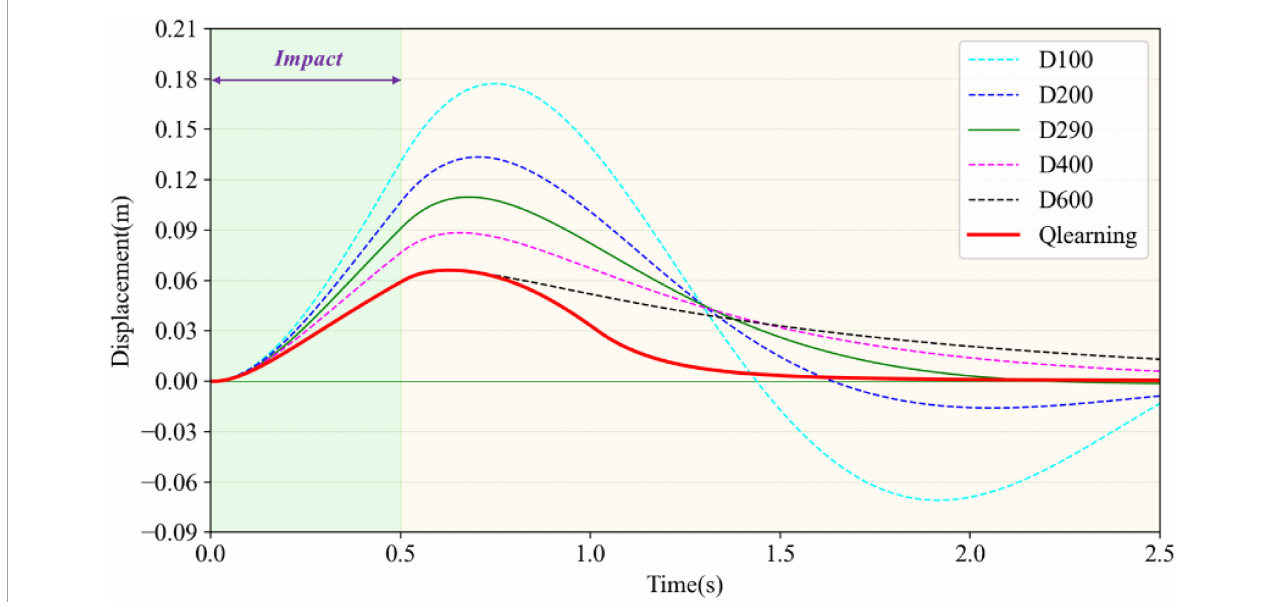
FIGURE7 Comparison of load recovery trajectories under different damping values after impact.